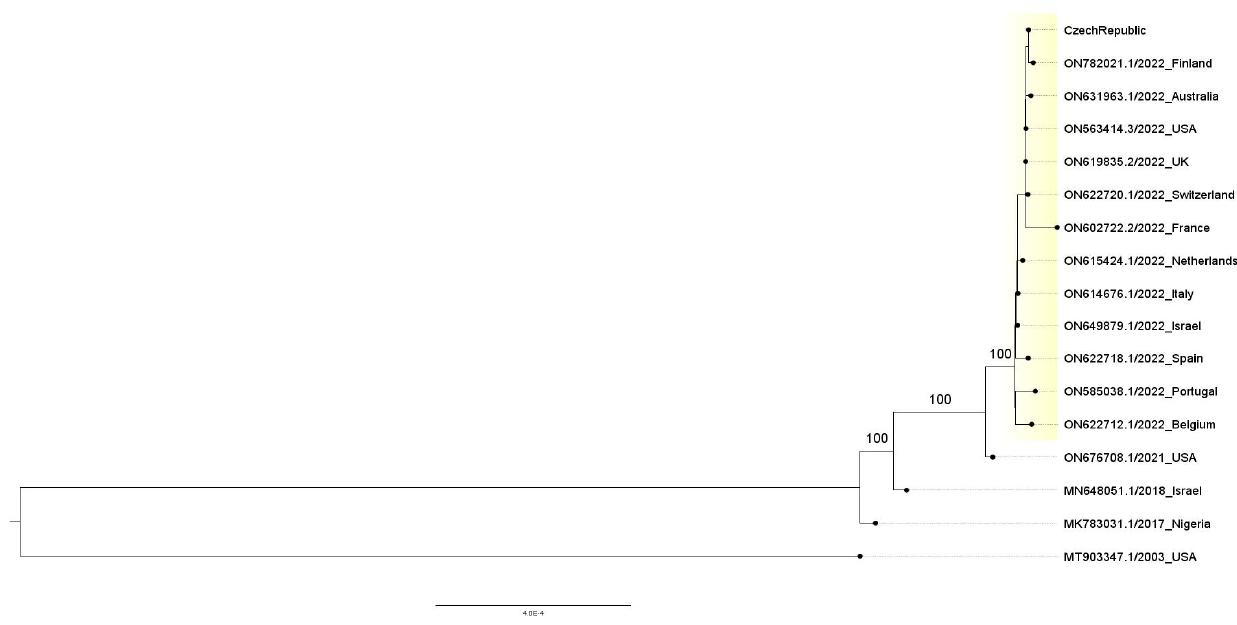
Figure 2. Maximum-likelihood phylogenetic tree: samples presumably originating from the current Monkeypox outbreak are highlighted; only (relevant) bootstrap values >85 were